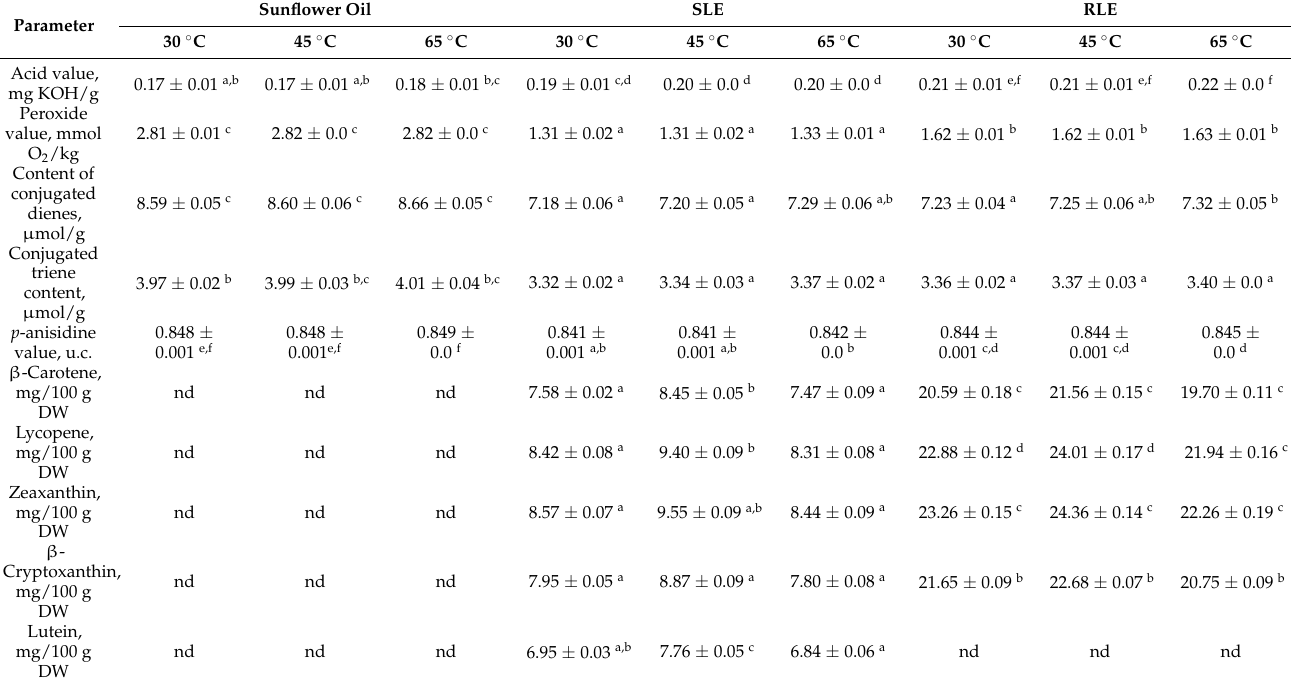
Table 3. The influence of temperature on the physicochemical parameters and carotenoid content of the sea buckthorn and rose hip lipophilic extracts and sunflower